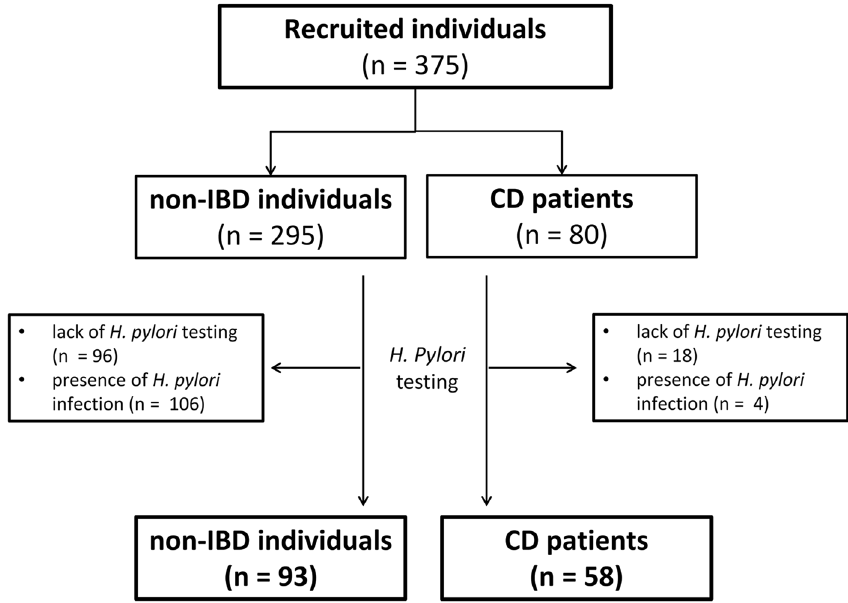
Figure 1. Chart demonstrating flow of patients initially recruited to the study and those included into the final analyses after evaluation of the status of H. pylori infection. CD Crohn’s disease, IBD inflammatory bowel